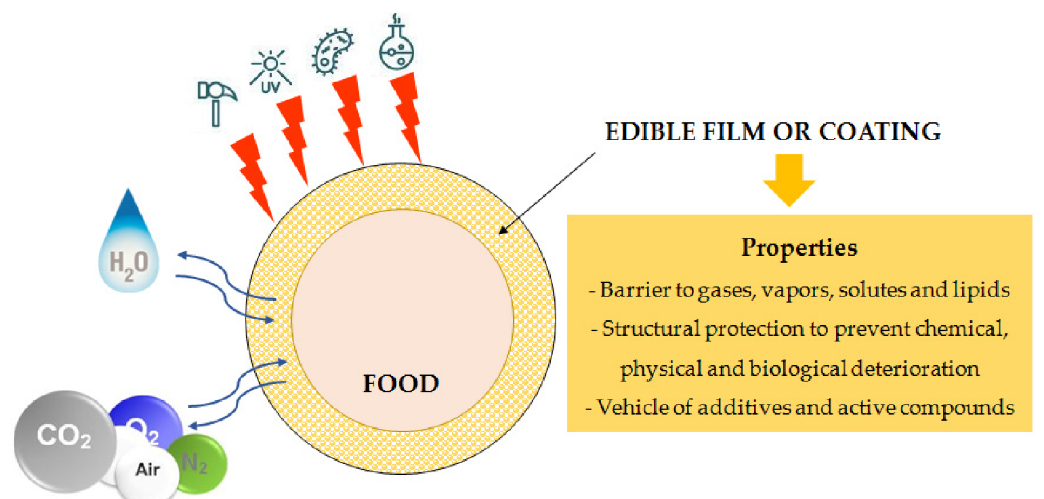
Figure 11. Schematic representation of the advantages of edible food coatings (taken from [22] under Creative Commons License).